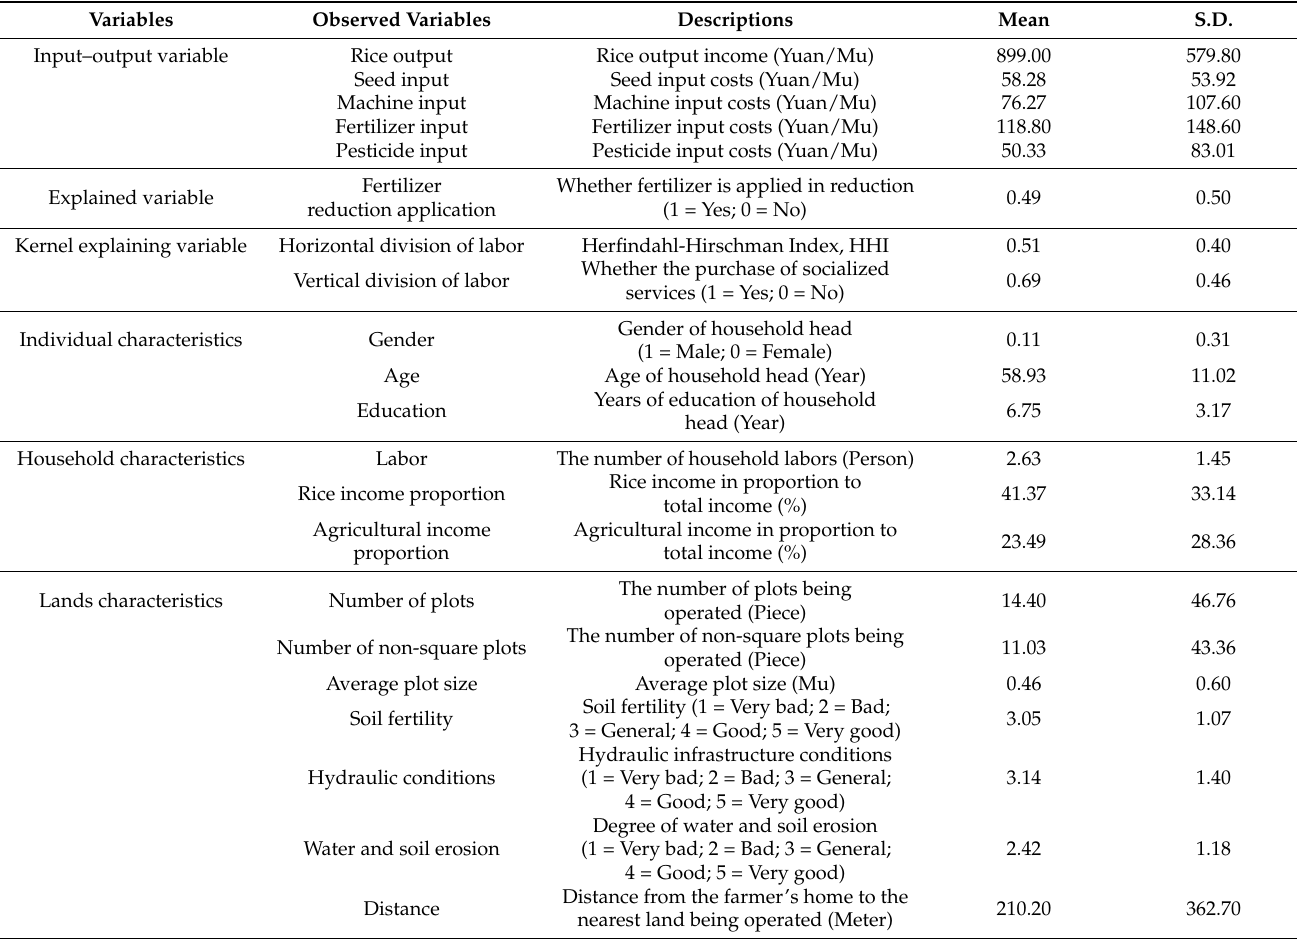
Table 1. Variable definition and descriptive